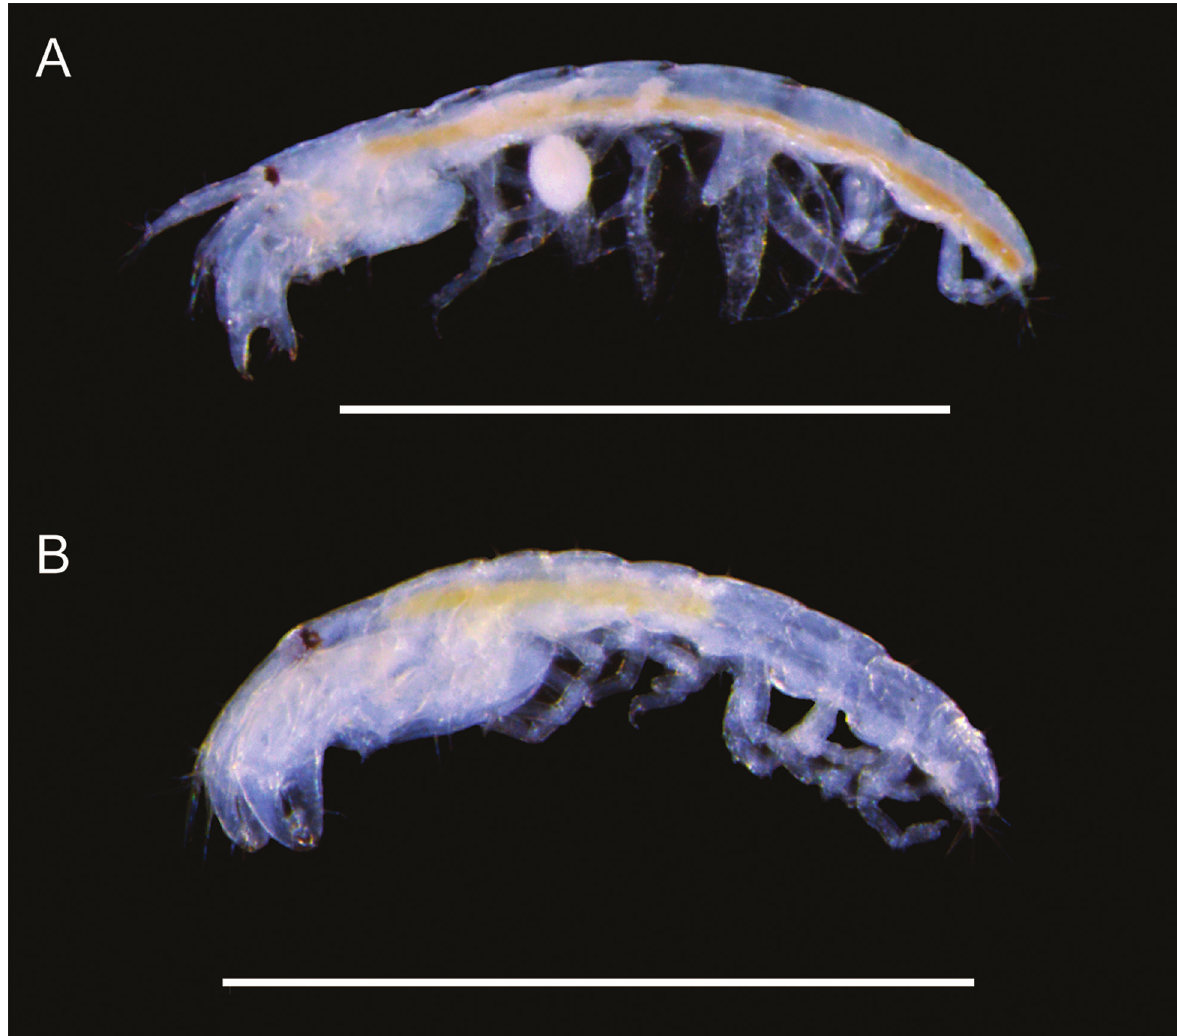
Figure 8. Digital image of Pseudozeuxo fischeri sp. nov. paratype female (MNRJ 29869) and allotype male lateral (MNRJ 29868). Female, TL 1.2 mm; Male, TL 1.0 mm. Scale bar: 1.0